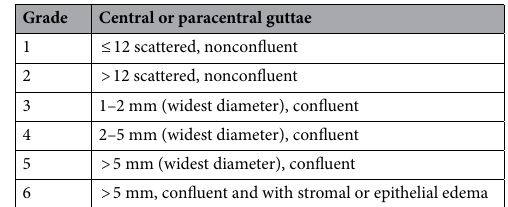
Table 1. FECD Clinical Grading score (Louttit et al. 8